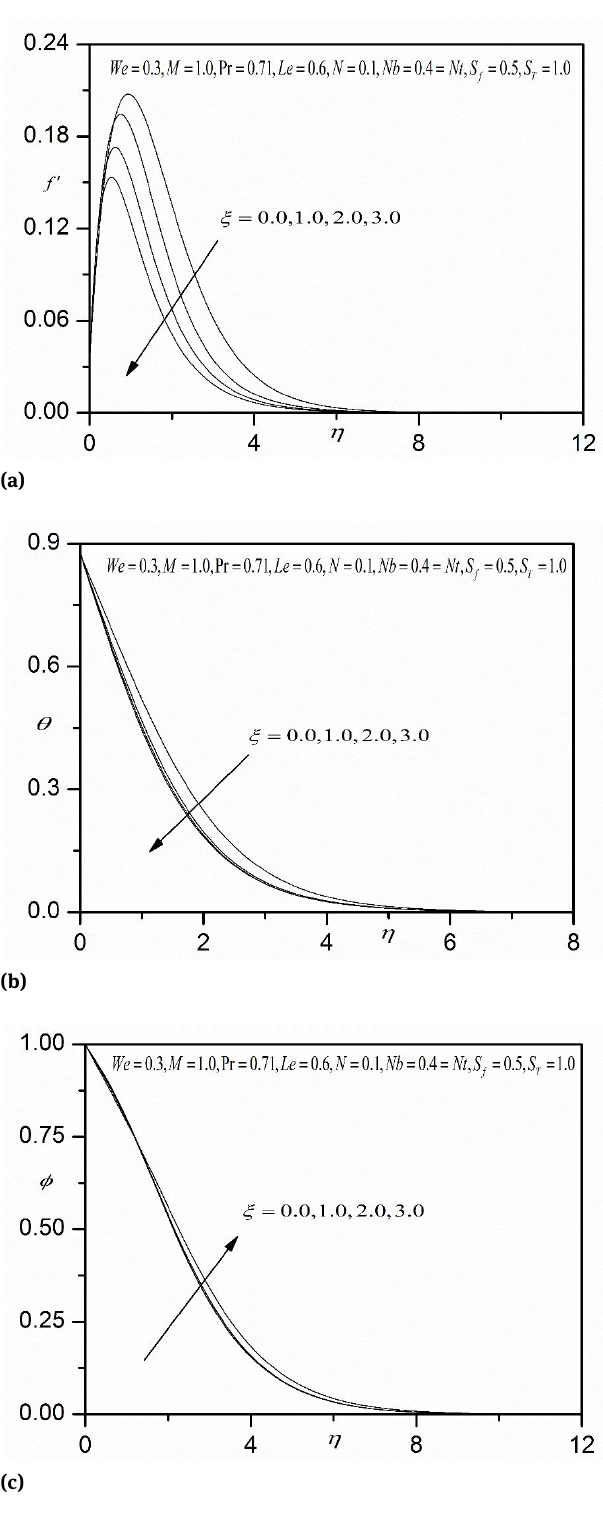
Fig. 12: (a) Effect of ξ on velocity profile; (b) Effect of ξ on tempera- ture profile; (c) Effect of ξ on concentration